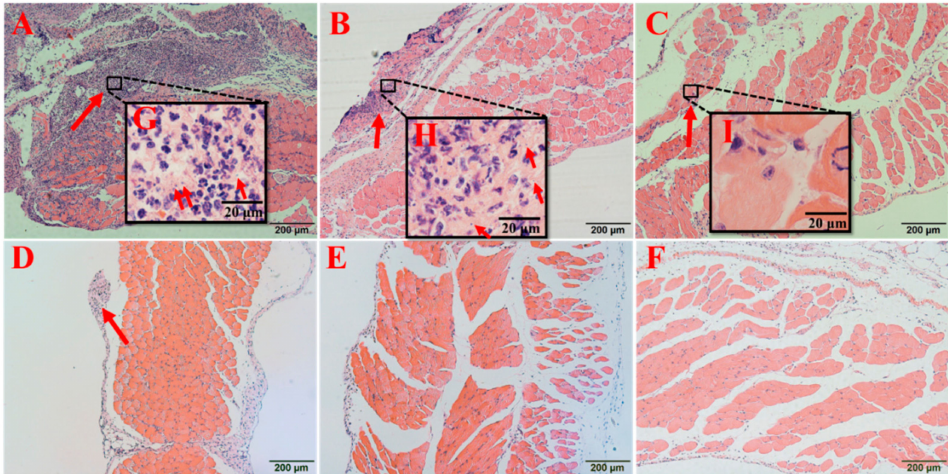
Figure 9. Pathological changes in the peritoneal tissues surrounding the implants after treatment. ( A ) PBS group, ( B ) thymol group (20 mg / kg), ( C ) vancomycin group (40 mg / kg), ( D ) low-dose combination treatment group (vancomycin hydrochloride 40 mg / kg + thymol 5 mg / kg), ( E ) middle-dose combination treatment group (vancomycin hydrochloride 40 mg / kg + thymol 10 mg / kg), and ( F ) high-dose combination treatment group (vancomycin hydrochloride 40 mg / kg + thymol 20 mg / kg). Magnification: 100 × in (A–F); 1000 × in (G–I). Red arrows express infiltration of inflammatory